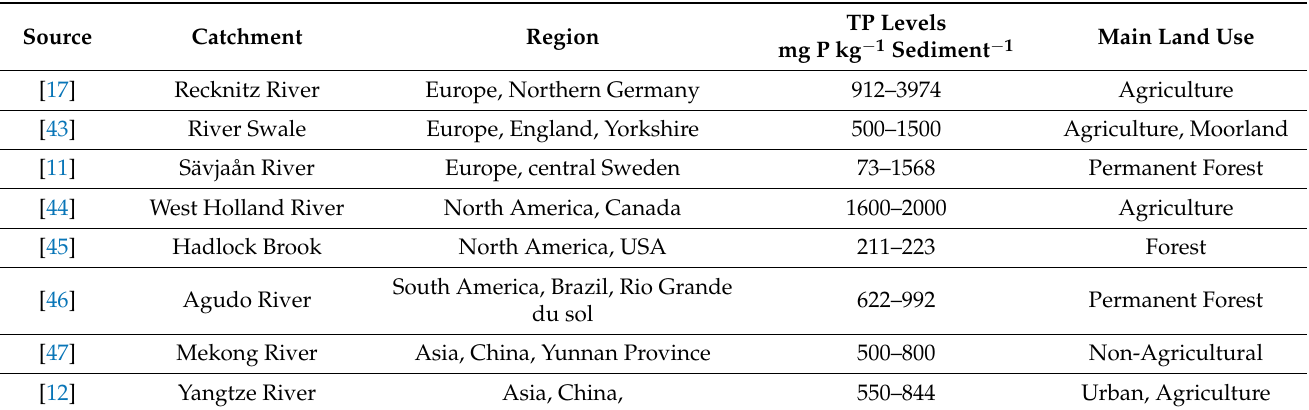
Table 2. Different total P contents of river ed sediments